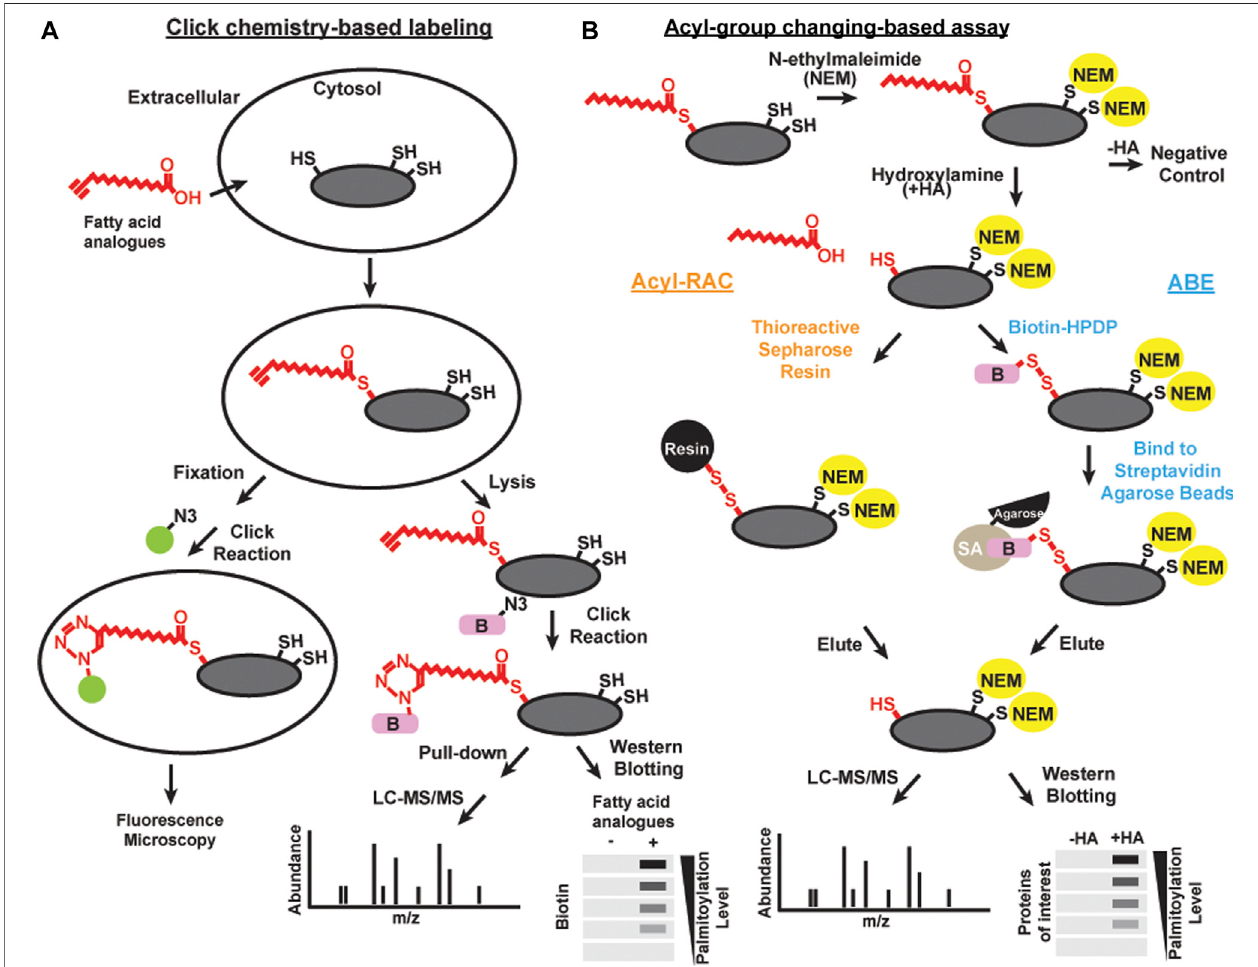
FIGURE 1 | Schematics of methods of detecting acylation Click chemistry-based labeling (A) and acyl-group changing-based assay (B) can be combined with various detection methods, including microscopy, liqued chromatography and tandem mass spectrometry (LC-MS/MS), and western blotting, to detect S-acylated